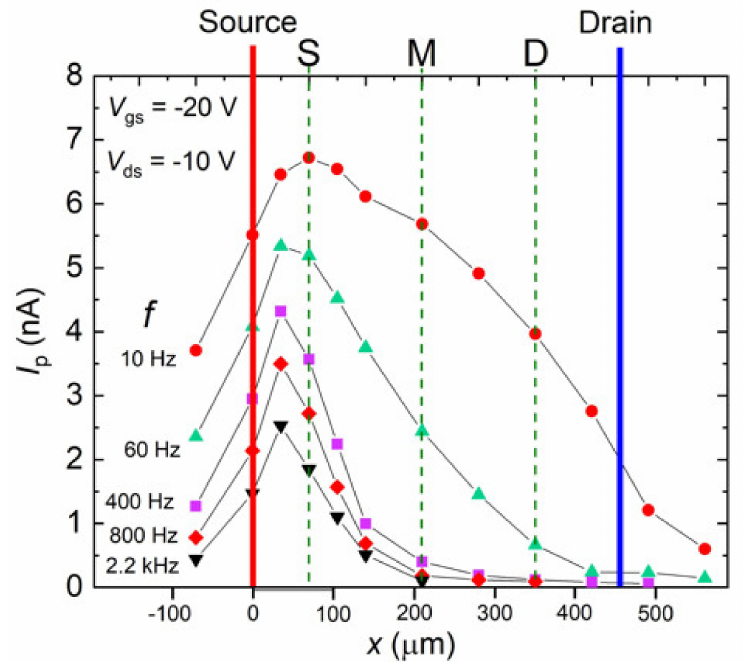
Figure 3. Photocurrent I p (x) as a function of distance x from the source edge for the indicated chopper frequencies f : 10 Hz (red circles), 60 Hz (green up triangles), 400 Hz (magenta squares), 800 Hz (red diamonds), 2.2 kHz (black down triangles). An overall reduction in I p (x) that is relatively stronger on the drain side is produced by increasing f